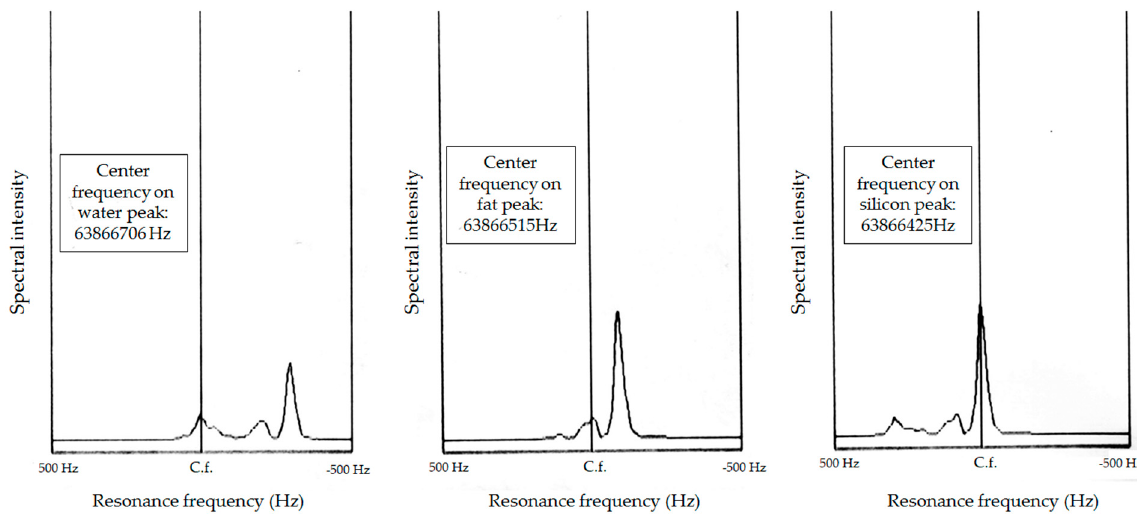
Figure 5. Magnetic resonance spectroscopy results for water, fat, and silicone.